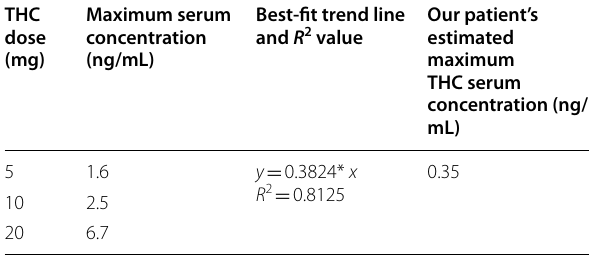
Best-fit trend line and R 2 value